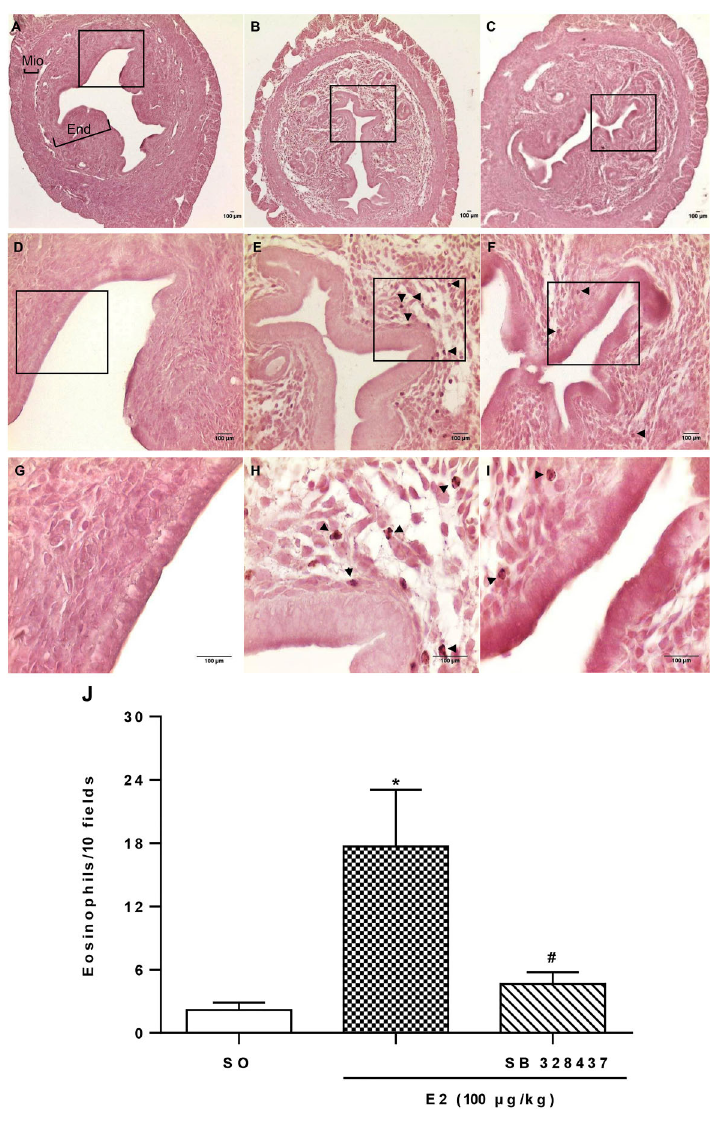
Figure 3. Effect of CCR3 antagonism on 17- b - estradiol (E2)-in fl uenced eosinophil migration and uterine edema. Cross-sections of uterine tissue (5 m m) of ovariectomized C57BL/6 mice stained with orcein. The animals were injected with sesame oil (SO) ( A , D , G ), E2 (100 m g/kg; B , E , H ), or E2 and SB 328437 (3 mg/kg; C , F , I ) and 24 h later the uteruses were collected (n=5). In panel A , the black bars show the uterine regions of the myometrium (Mio), and endometrium (End). The regions represented by A – C , D – F or G – I are photographs at 10, 40, and 100 (cid:1) magni fi cation, respectively; scale bars: 100 m m. The arrows indicate eosinophils stained with orcein. J , Eosinophil quanti fi cation as the aver- age count of 10 fi elds (n=5). Data are reported as means ± SE. *P o 0.05 compared to SO and # P o 0.05 compared to E2 alone (one-way ANOVA with Tukey post hoc